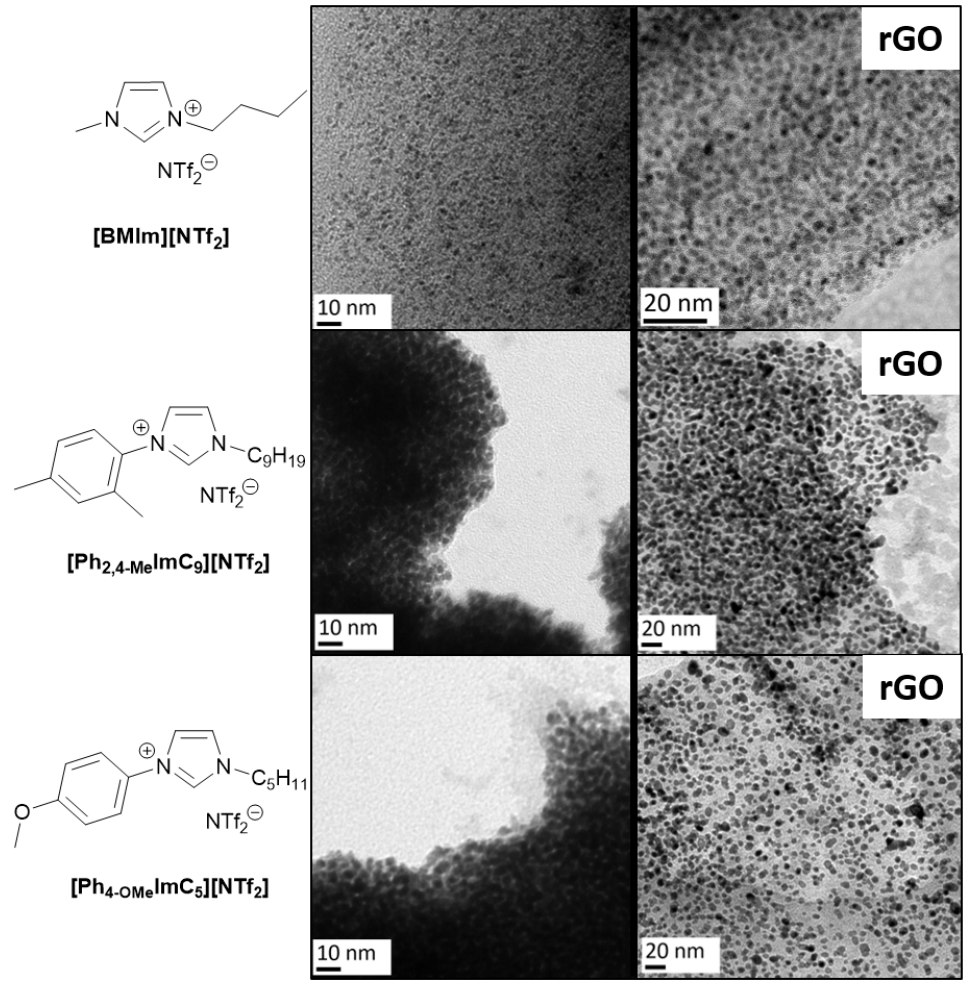
Figure 2. TEM images of Pt-NPs and Pt-NP@rGO composites obtained in the IL (from top to bottom) [BMIm][NTf 2 ] ( M4-1, M4_rGO-1/1 ) and the TAAILs [Ph 2,4-Me ImC 9 ][NTf 2 ] ( DMP9-1, DMP9_rGO-